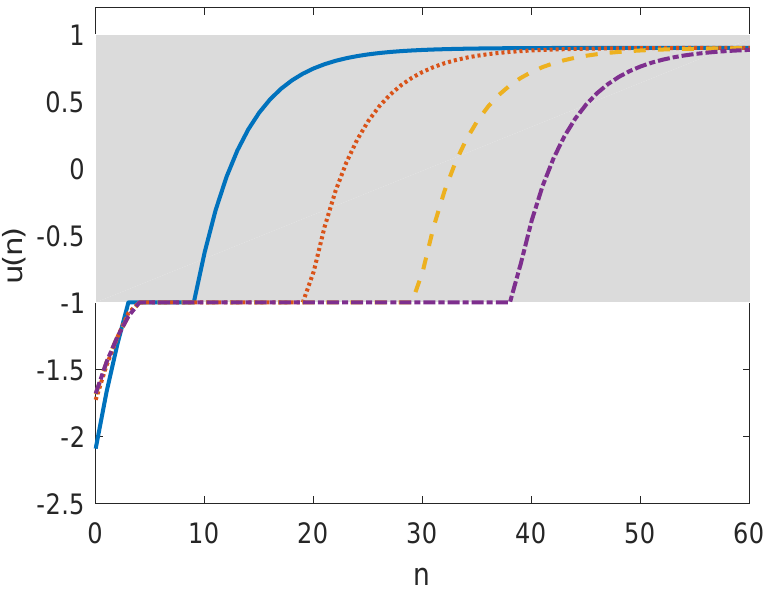
Figure 3. Closed-loop input trajectories of EMPC in Equation (10) with x ( 0 ) = 5, c 1 = 10 4 and c 2 = 10 4 , N = 10 (solid), N = 20 (dotted), N = 30 (dashed), N = 40 (dash dotted),